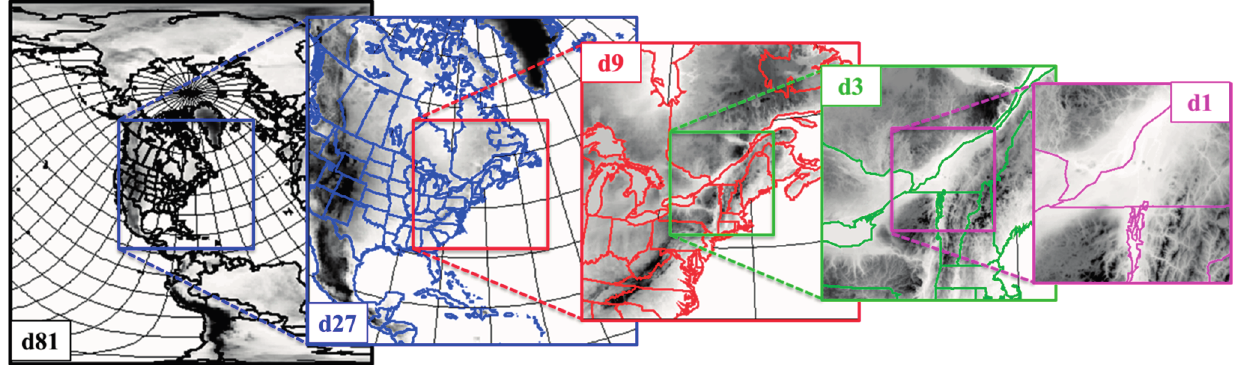
Figure 2. The computational domains used for the fifth-generation Canadian Regional Climate Model (CRCM5) cascade: d81 (0.81°; black), d27 (blue), d9 (red), d3 (green) and d1 (magenta) simulations. The domains are square and centered on Montréal (Québec, Canada). The grey tones represent the topography definition in each domain (see the legend of Figure